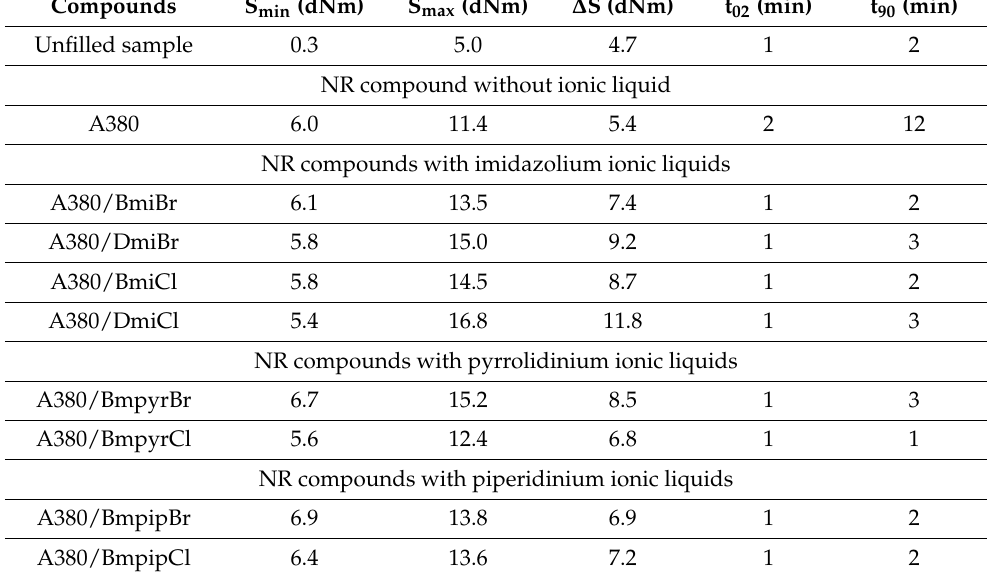
Table 3. Cure characteristics at 160 ◦ C of NR compounds filled with nanosized silica (S min , minimum torque; S max , maximum torque; ∆ S, torque increase; t 02 , scorch time; t 90 , optimal vulcanization